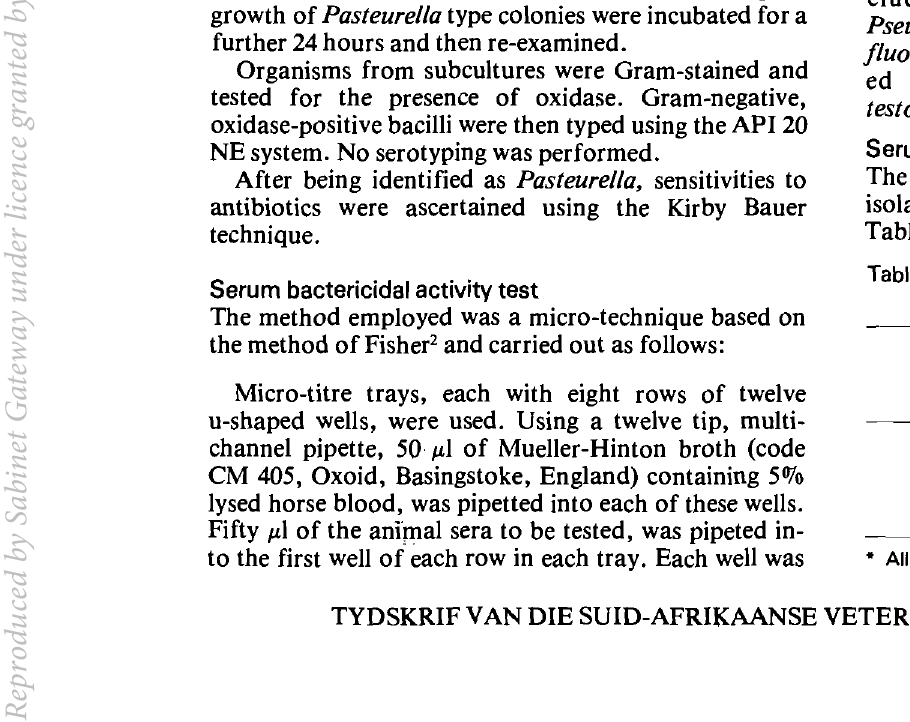
Table 1: Results of the antibiotic sensitivities of four Pasteurella